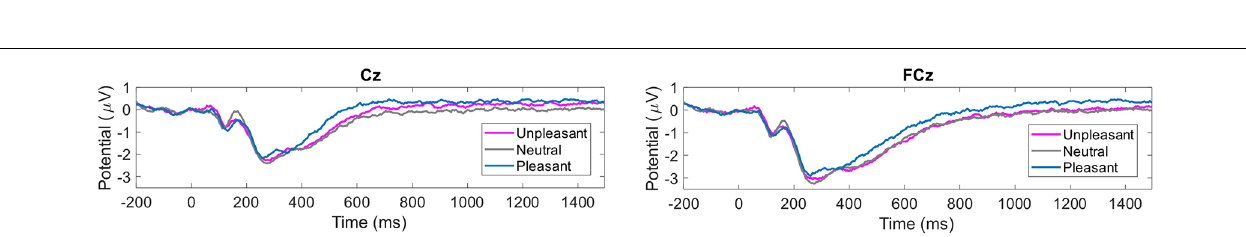
Frontiers in Human Neuroscience |